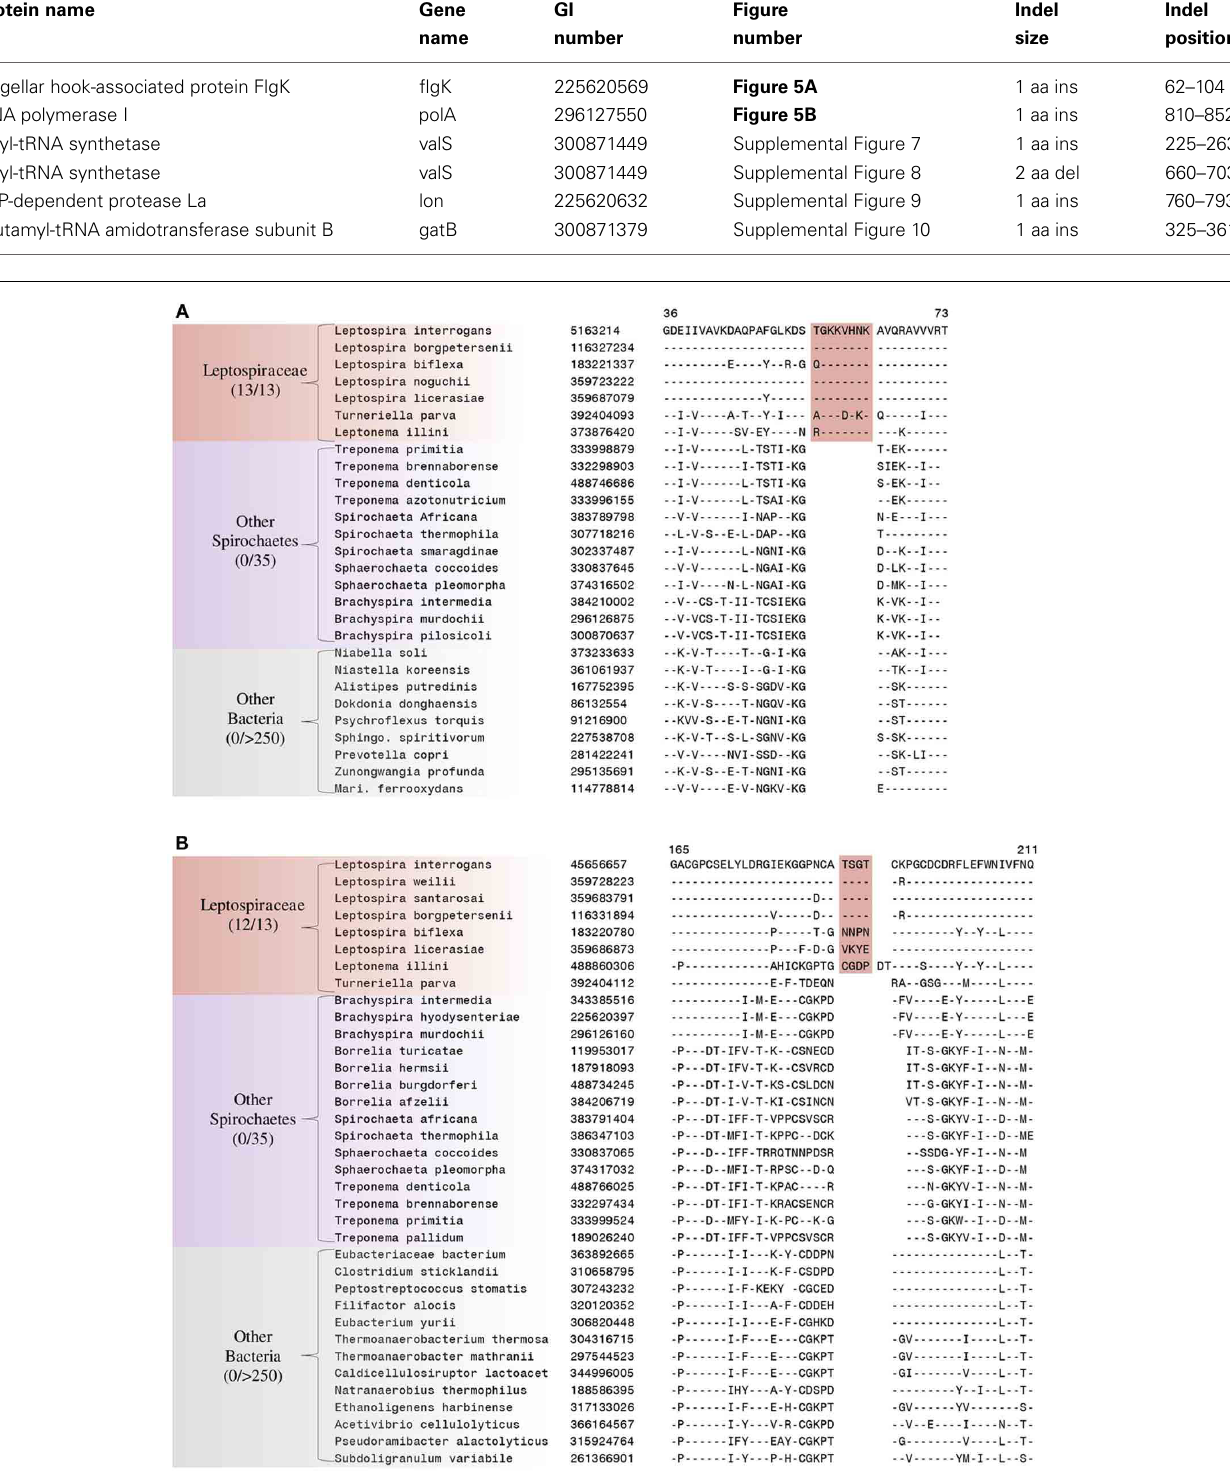
FIGURE 6 | Partial sequence alignments of (A) 50S Ribosomal protein L14 and (B) Alanyl-tRNA synthetase, showing two CSIs that are specific for the family Leptospiraceae , but not found in the sequence